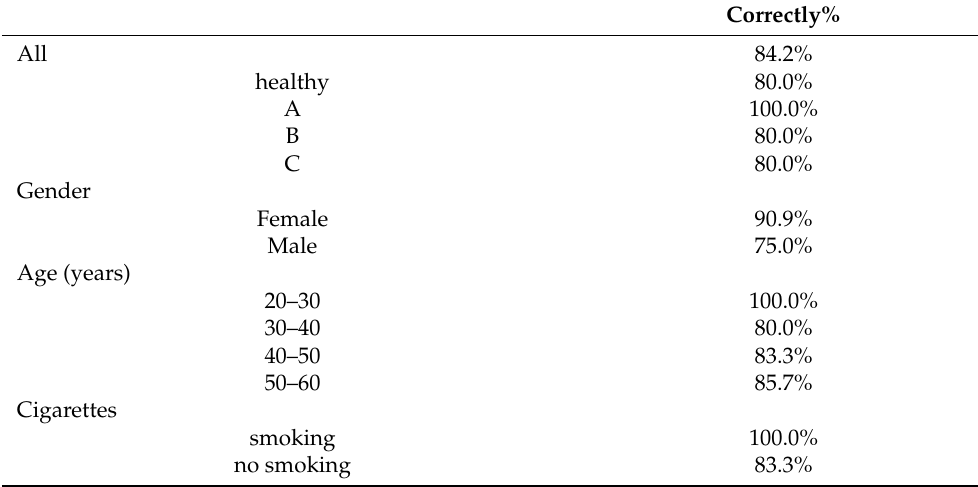
Table 6. The quality of the neural network according to the